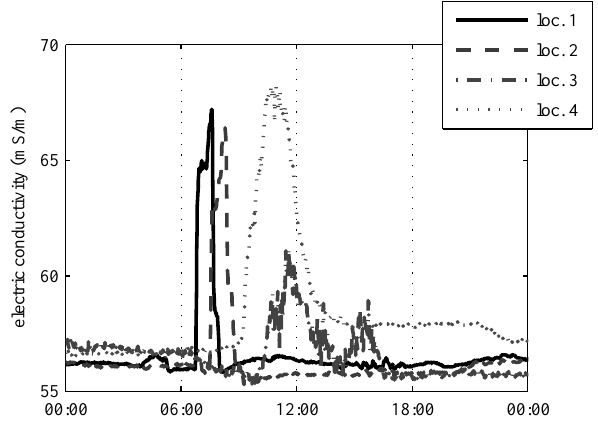
Figure 6. Measured EC at locations 1–4 at Thursday, 4 Septem- ber 2008. The EC at location 4 has a 24h delay and is connected to the pulse that left the booster station at Wednesday, 3 Septem- ber